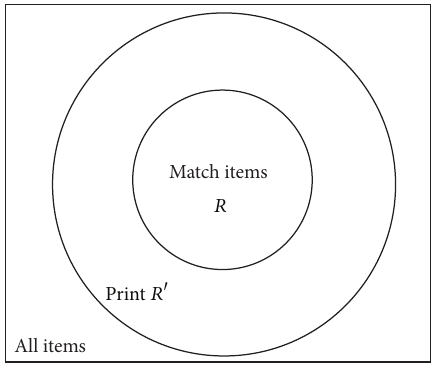
Figure 1: Relationship between profiteering stage set and match